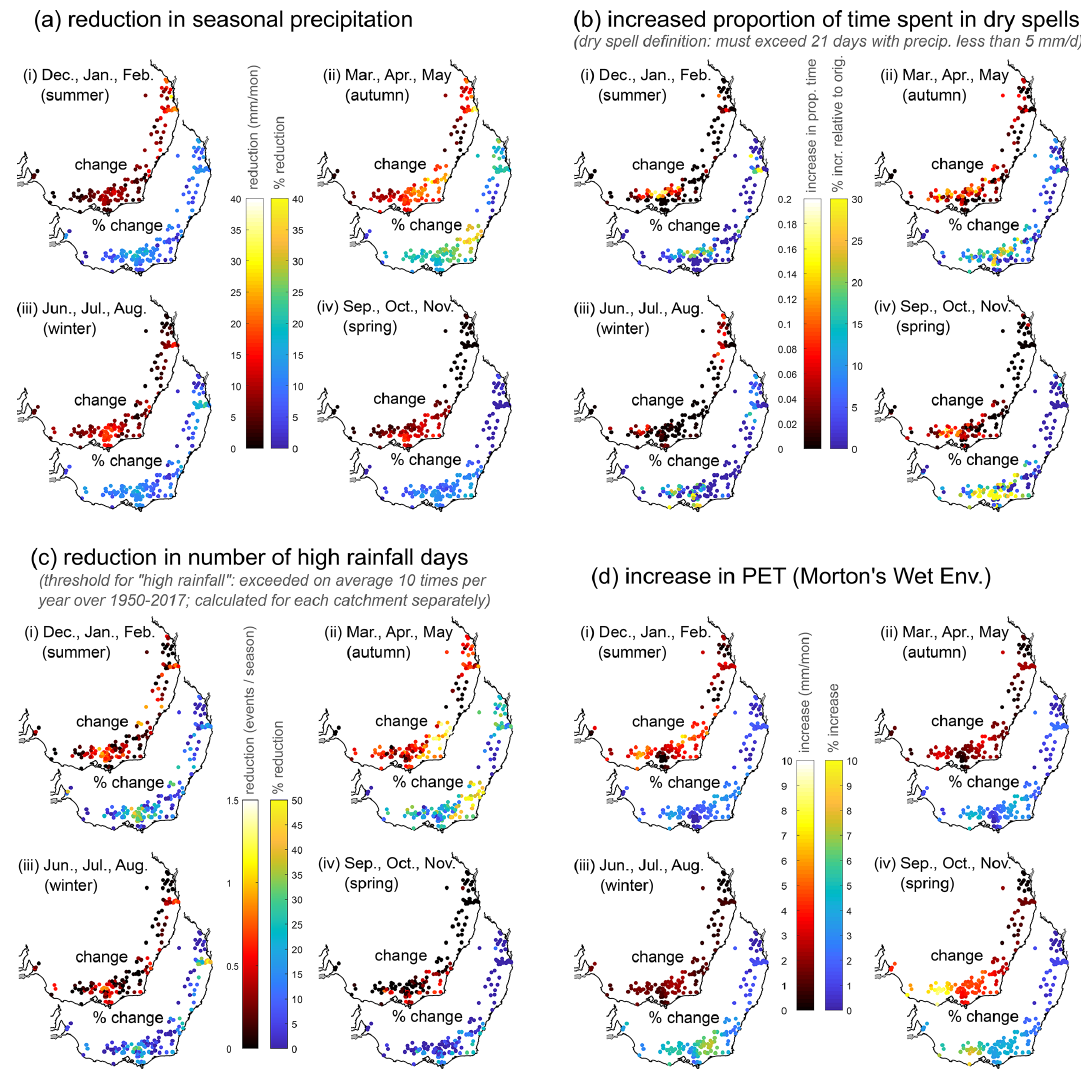
Figure 3. Change in selected climatic statistics during the Millennium Drought (taken as April 1997 to August 2010, inclusive) compared to the long-term average (taken as calendar years 1950 through 2017, inclusive) for each season. Each dot corresponds to a single catchment; values plotted are areal averages sourced from Fowler et al.